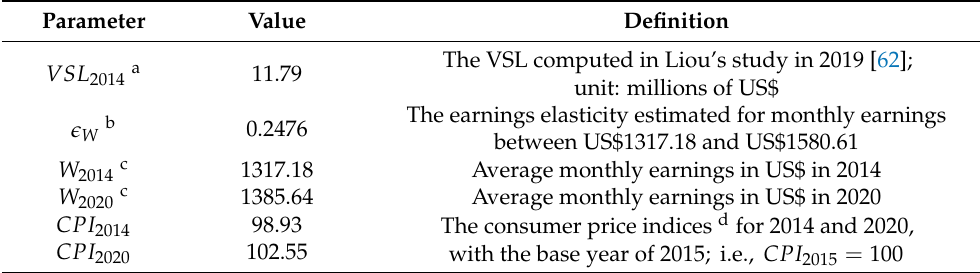
Table 5. Relevant parameters for the VSL